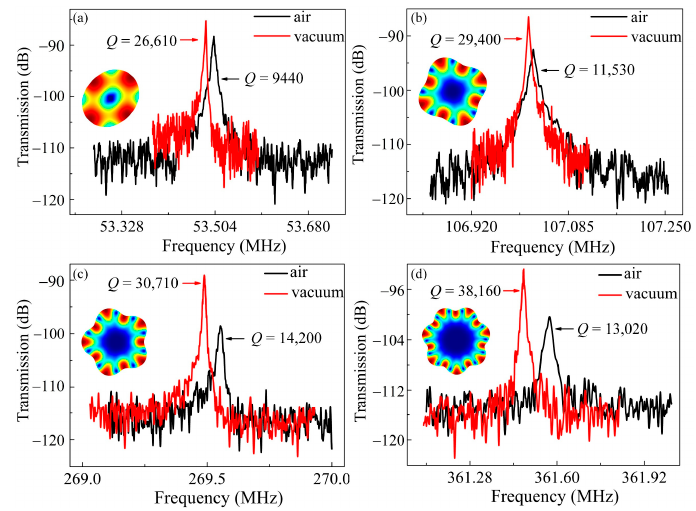
Figure 4. The frequency responses in air and vacuum for the 2nd and 4th WGMs of the 37 µ m-radius resonator ( a , b ) as well as for the 5th and 7th WGMs of the 18 µ m-radius resonator ( c , d